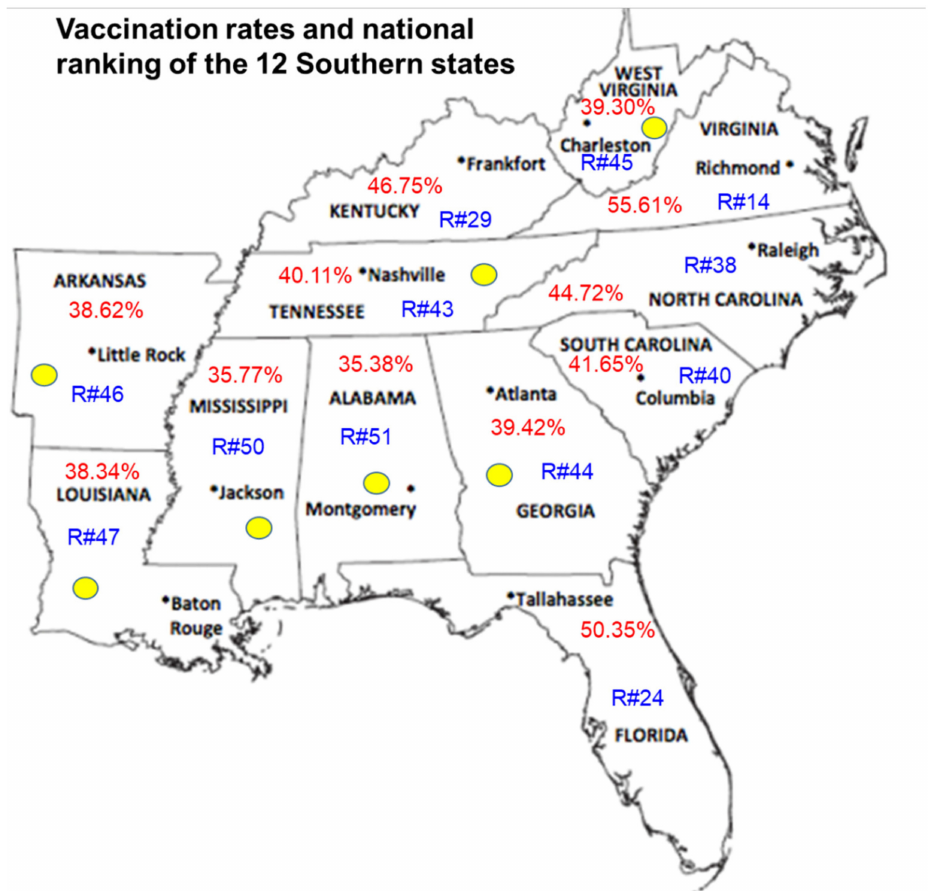
Figure 1. Vaccination rates and national rankings of the 12 Southern states. Vaccination rates within the 12 Southern states are reflected in red text, vaccination rate rankings in the U.S. are reflected in blue text, and states with the lowest vaccination rates in the South are identified with yellow ovals. Vaccination rates were obtained from a statewide https: //www.tn.gov/health/cedep/ncov/data.html (accessed on 21 July 2021), vaccine tracker